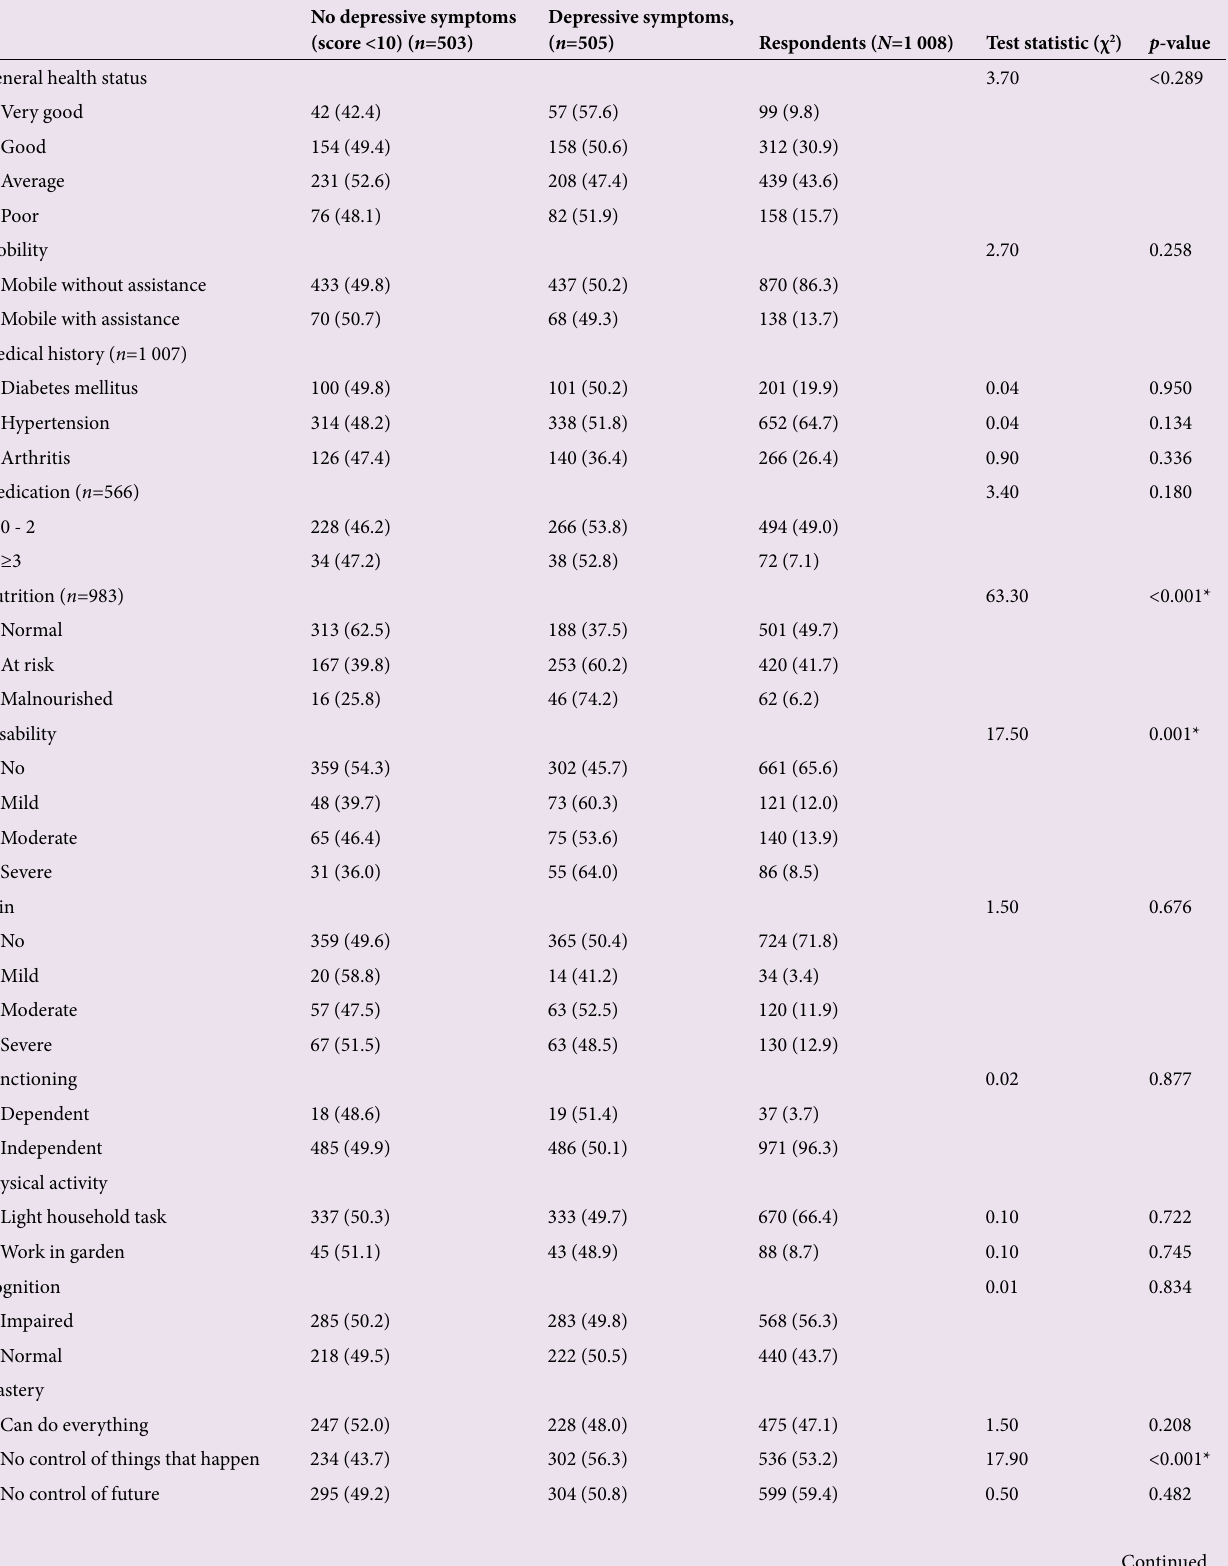
Table 3. Health-related and social risk factors by depressive symptom